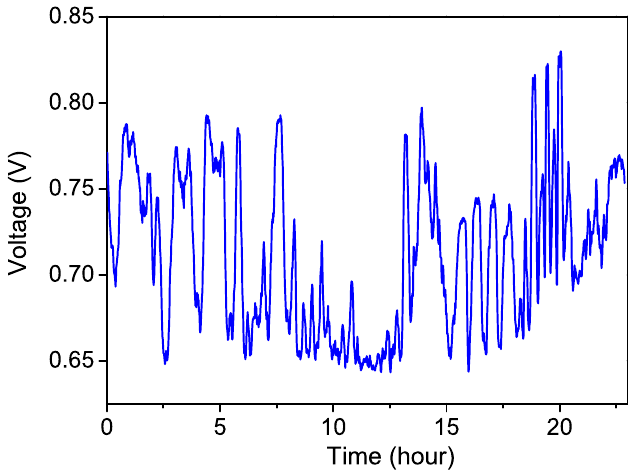
Figure 6. Power of the Raman laser in free running.